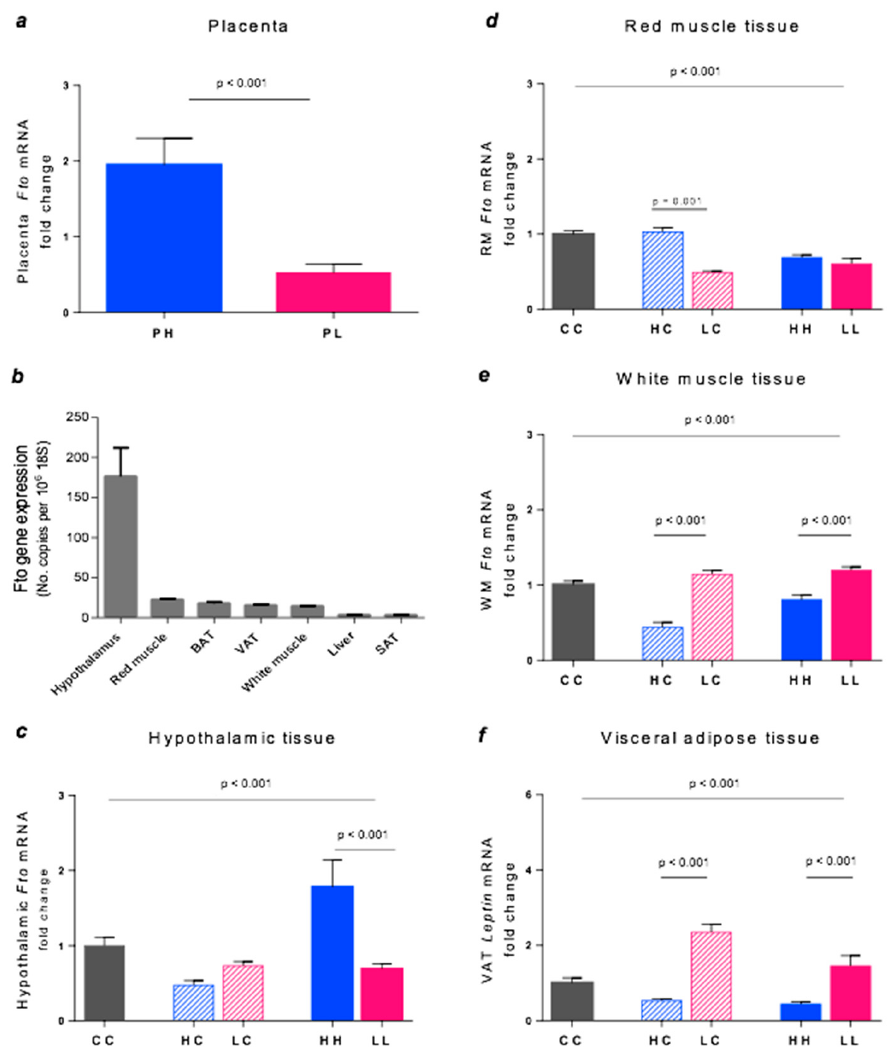
Figure 4. Fto gene expression in ( a ) placenta, ( b ) all tissues of 20-week CC mice, ( c ) hypothalamus, ( d ) RM, ( e ) WM, and ( f ) VAT. Data represent the mean ± SEM. ( a ) PH n = 15, PL n = 18. ( b ) Values were calculated for control mice (CC) and expression of Fto is relative to 18S. ( c ) CC n = 7, HC n = 6, LC n = 10, HH n = 5, LL n = 6. ( d ) CC n = 7, HC n = 7, LC n = 6, HH n = 6, LL n = 6. ( e ) CC n = 5, HC n = 5, LC n = 4, HH n = 5, LL n = 5. ( f ) CC n = 5, HC n = 7, LC n = 6, HH n = 7, LL n = 4.